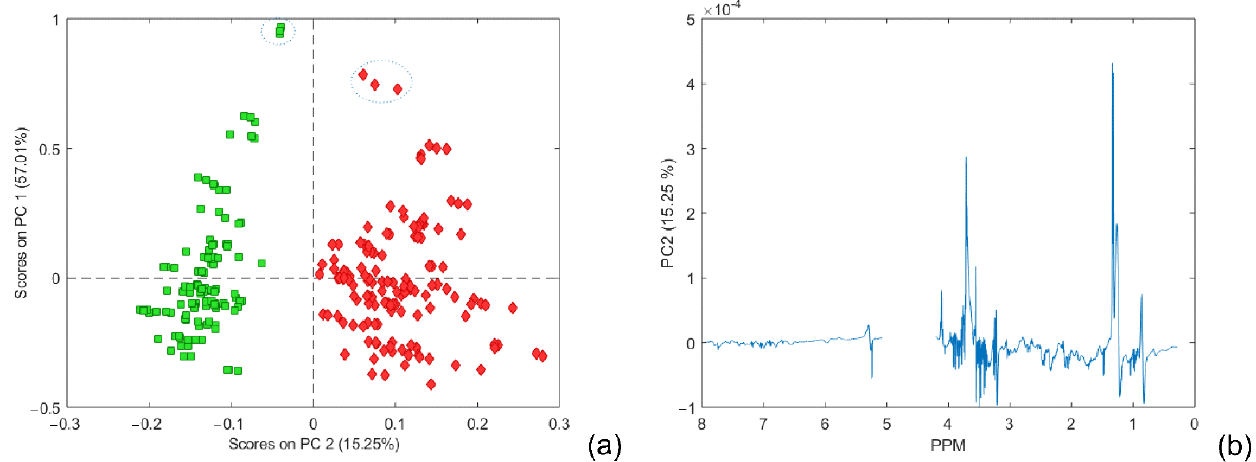
Figure 1. ( a ) PCA score plots of the first two components. The schizophrenia cohort is shown in red, and the control group in green. ( b ) PC2 back-scaled projection of loading coefficients. The empty part of the loading plot belongs to the water resonances